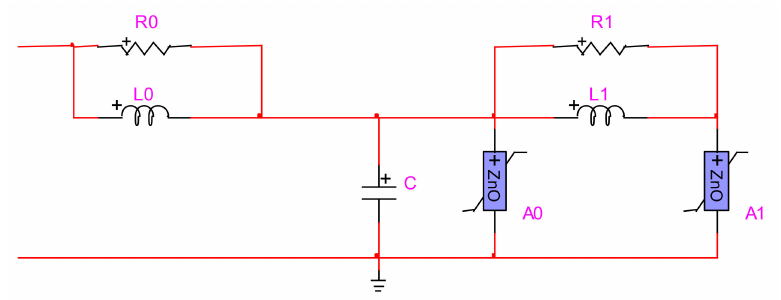
Figure 4. Frequency-dependent metal oxide surge